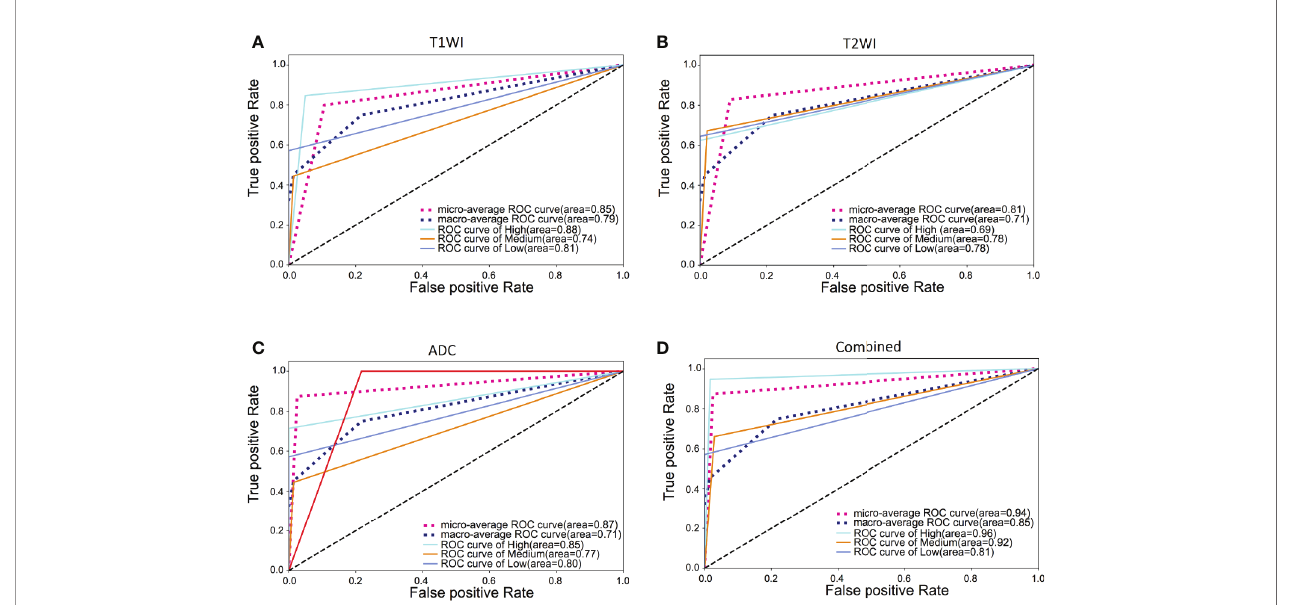
FIGURE 3 | ROC curves based on radiomics features extracted from three MRI sequences and combined three MRI sequences for classi fi cation of three risks of GISTs. (A) micro-average of 0.85 on T1WI. AUC of 0.88, 0.74, and 0.81 for the diagnosis of high-risk, intermediate-risk, and low-risk, respectively; (B) micro-average of 0.81 on T2WI. AUC of 0.69, 0.78, and 0.78 for the diagnosis of high-risk, intermediate-risk, and low-risk, respectively; (C) micro-average of 0.87 on ADC. AUC of 0.85, 0.77, and 0.80 for the diagnosis of high-risk, intermediate-risk, and low-risk, respectively; (D) micro-average of 0.94 in combined three MR sequences and AUC of 0.96, 0.92, and 0.81 for the diagnosis of high-risk, intermediate-risk, and low-risk,